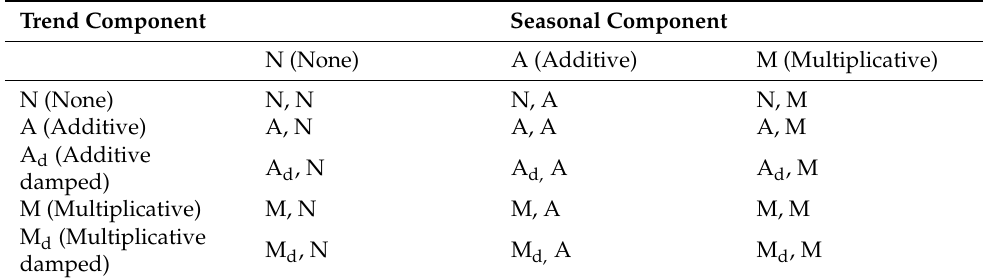
Table 2. The ETS-ES family models components with different